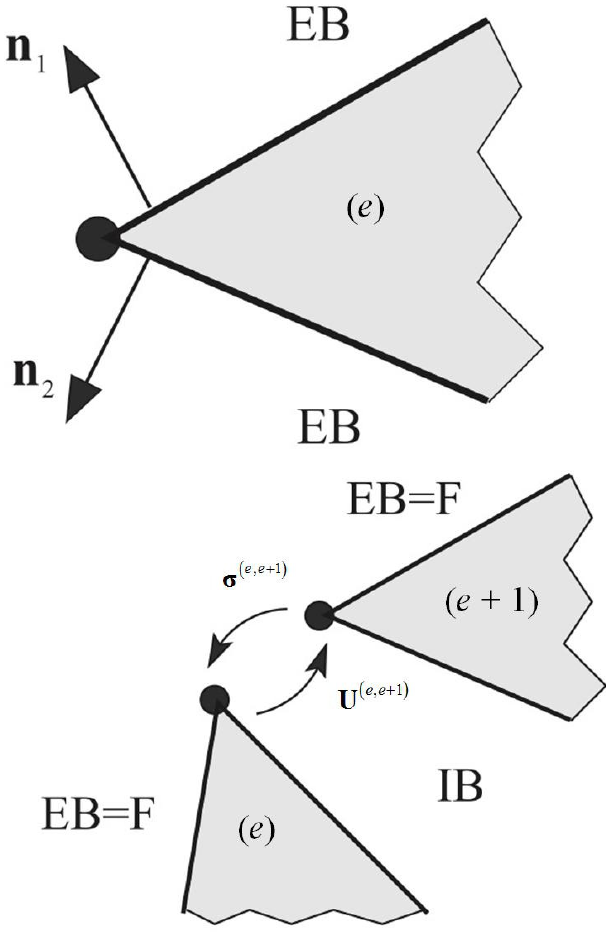
Figure 6: Definition of the external corners conditions for: a) a sin- gle element, two facing